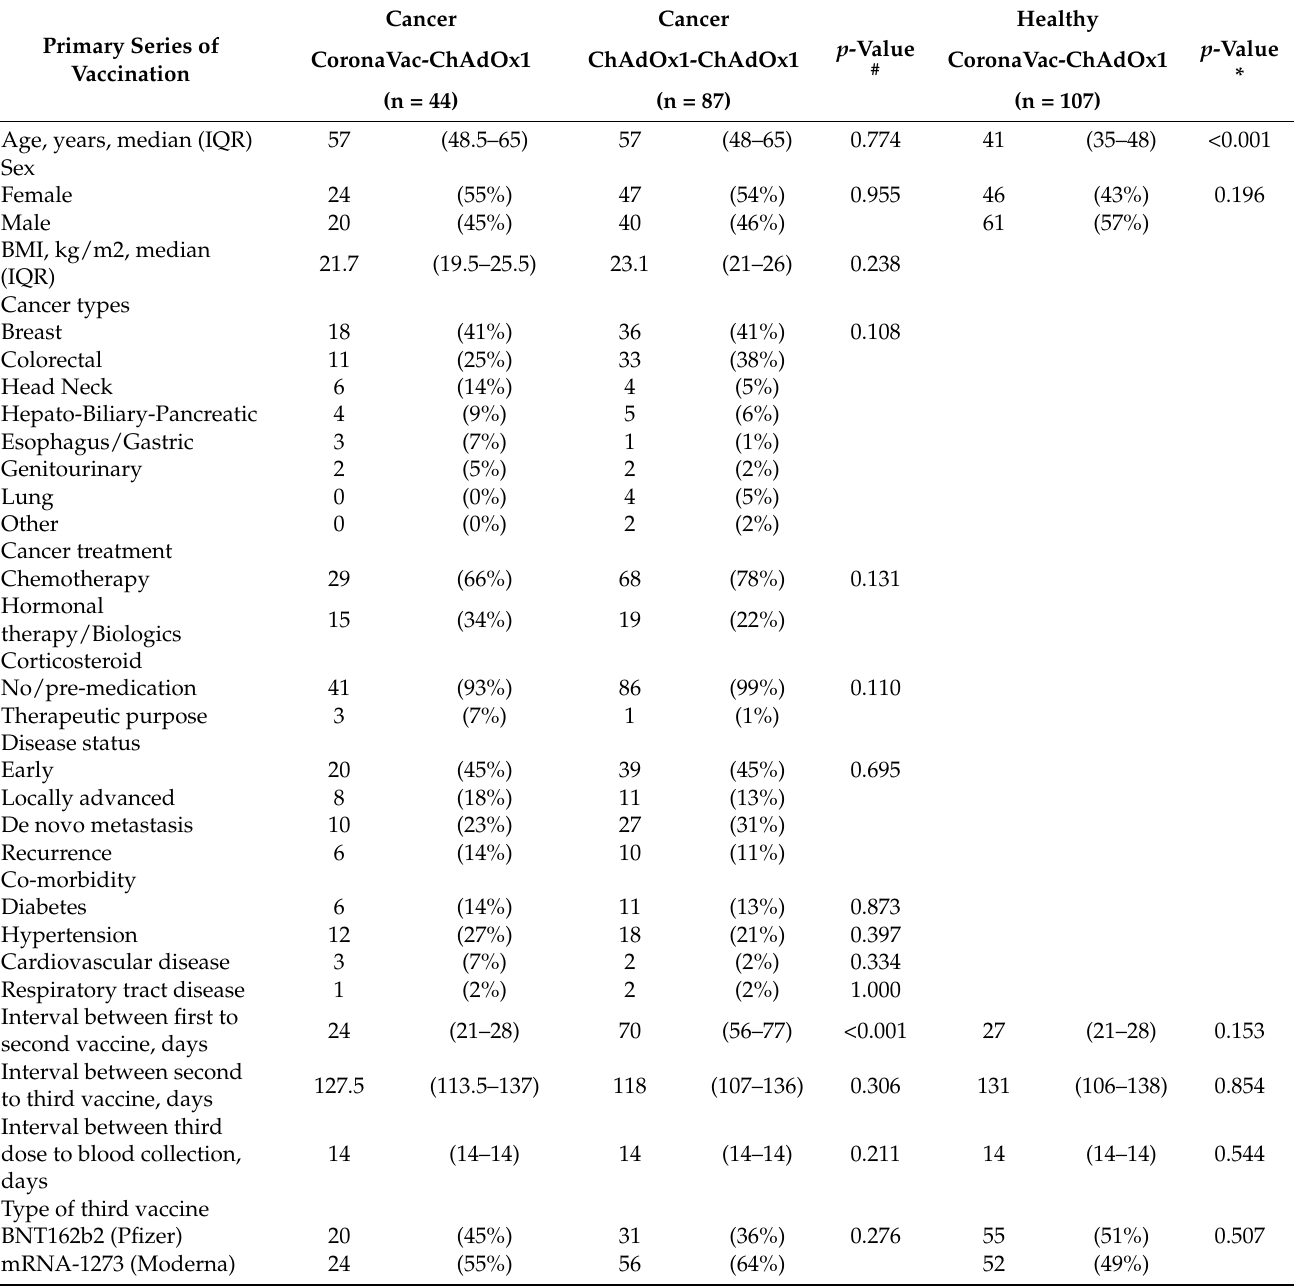
Table 1. Demographics and clinical